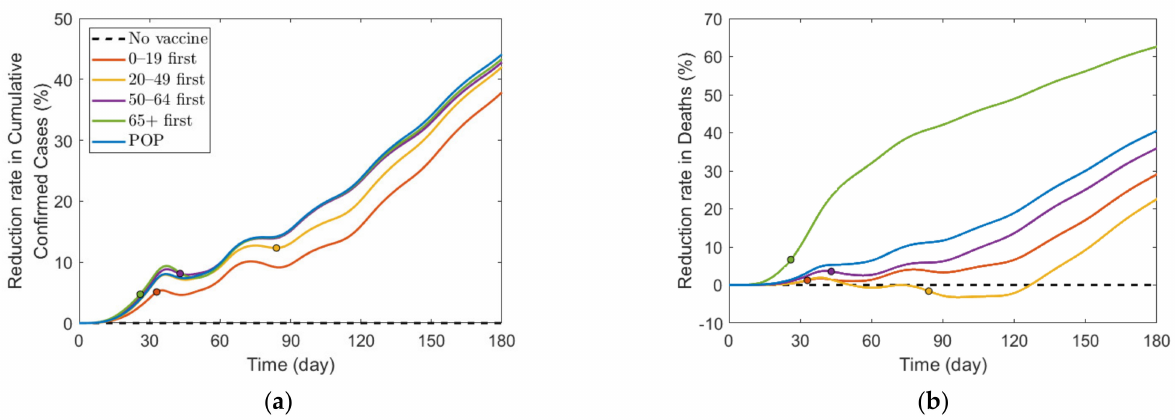
Figure 7. Effects of vaccination priority strategies when SD level changes adaptively according to the incidence. Time series of ( a ) reduction in cumulative confirmed cases and ( b ) reduction in